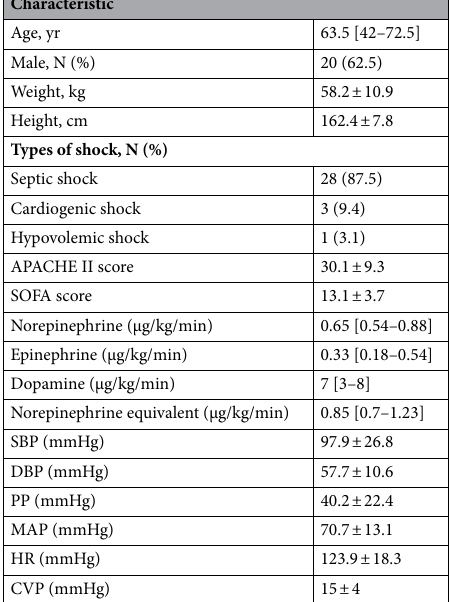
Table 1. Characteristics of the study population. APACHE: acute physiology and chronic health evaluation, CVP: central venous pressure, DBP: diastolic blood pressure, HR: heart rate, MAP: mean arterial pressure, PP: pulse pressure, SBP: systolic blood pressure, SOFA: sequential organ failure assessment.